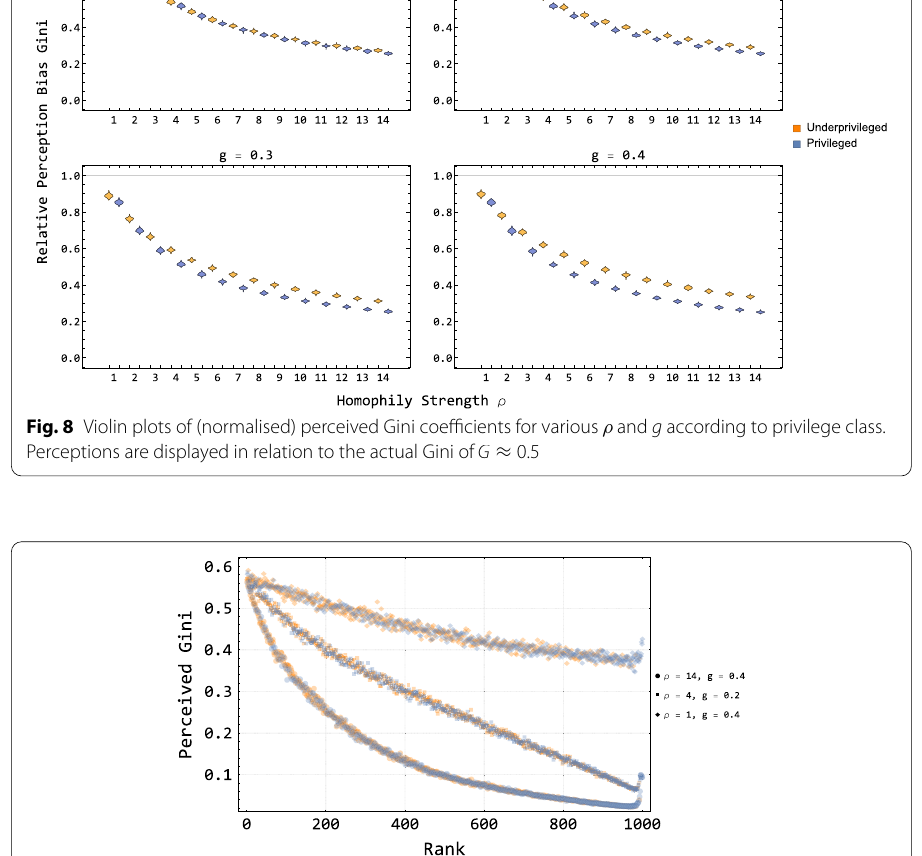
Fig. 9 Perception of the local Gini coefficients per income rank (increasing order) and according to privilege class (orange for the underprivileged, blue for the